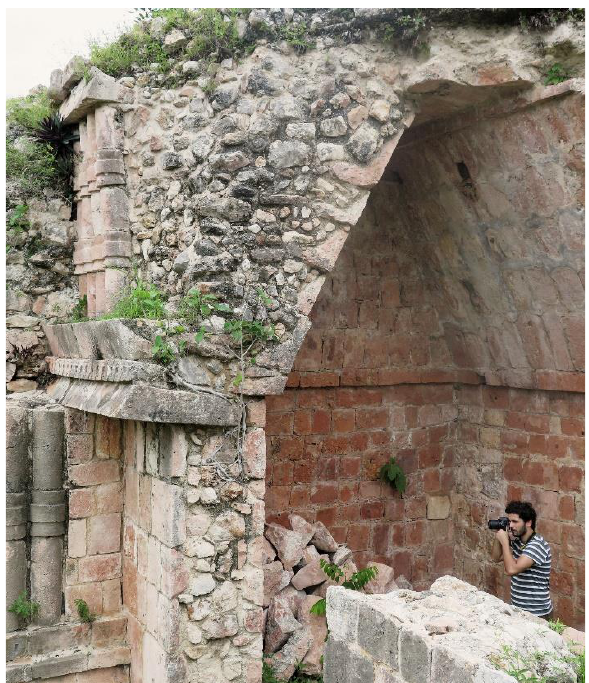
Figure 2. Field data collection in the archaeological site of Chacmultun (Yucatan, Mexico).